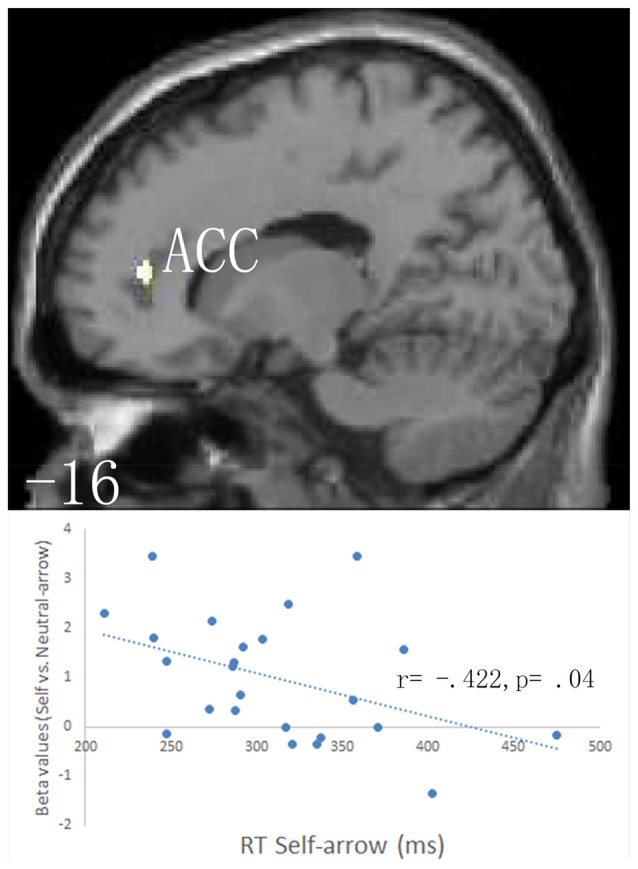
Based on anatomical masks outlined using the WFU PickAtlas tool, a small volume correction (SVC) procedure was employed separately to the a priori regions of interest: the bilateral anatomical structures in the anterior cingulate cortex (ACC)/ventromedial prefrontal cortex (vmPFC; BA 10/24/32), the precuneus/posterior cingulate cortex (PCC; BA 7/23/31), the frontal eye field (FEF; BA8), the ventral frontal gyrus (VFG; BA 44/45/47), and the left temporoparietal junction (TPJ; BA 22/39/40). The upper parts of the figure shows SVC analysis of responses to the self- vs. neutral-arrow conditions, which revealed significant activation only in the left ACC based on an anatomical mask; a cluster-level threshold of p < 0.05 (FWE-corrected) with a voxel-level threshold of p < 0.001 (uncorrected). The lower part of the figure shows the correlation between the behavioral RTs under the self-arrow condition and beta values for the self- vs. neutral-arrow in an 8-mm radius sphere centered on the peak voxel of activation in the left ACC.